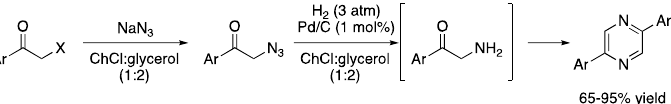
Figure 4. Hydrogenation of phenacyl azides.